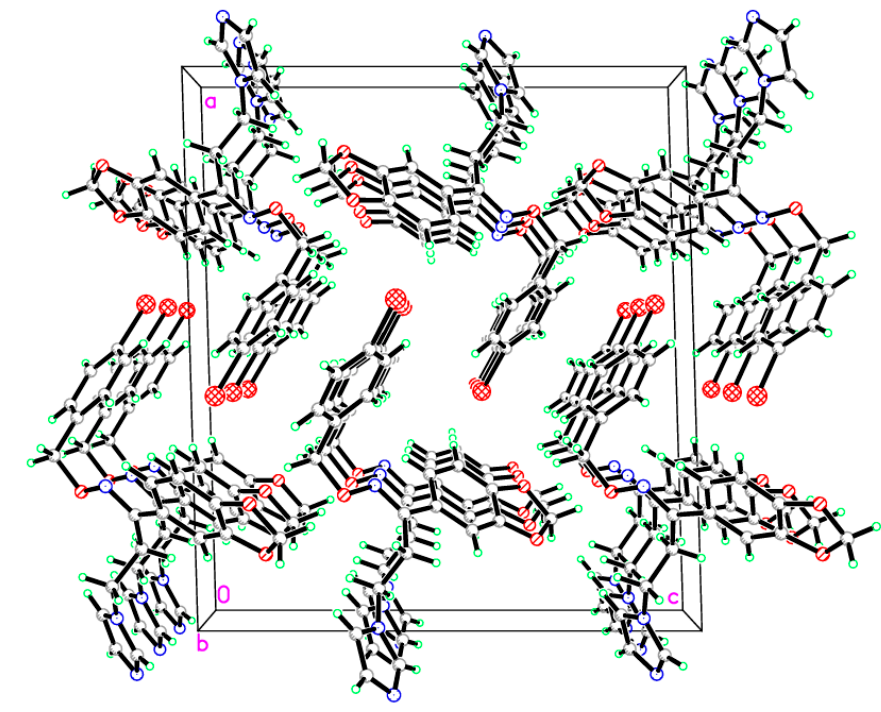
Figure 3. Molecular packing of compound Vi .